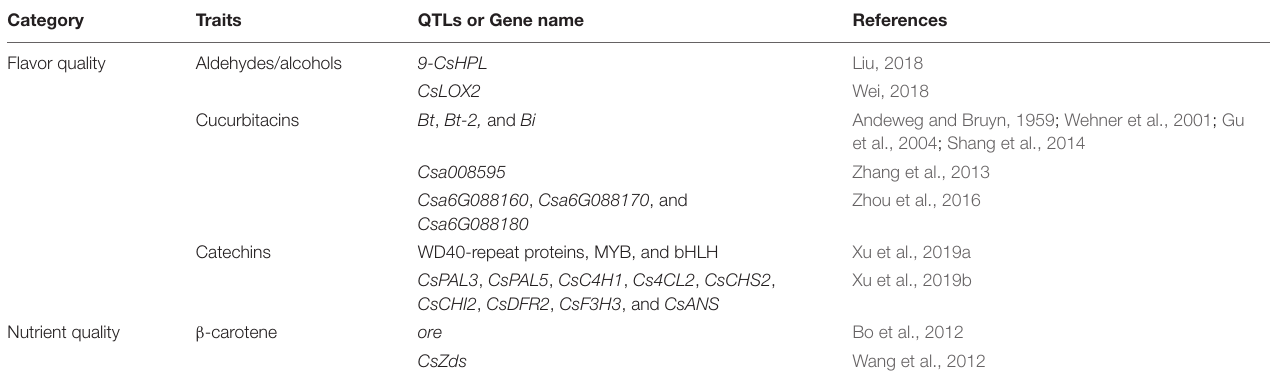
TABLE 2 | Genes related to the nutrient quality and flavor quality of cucumber